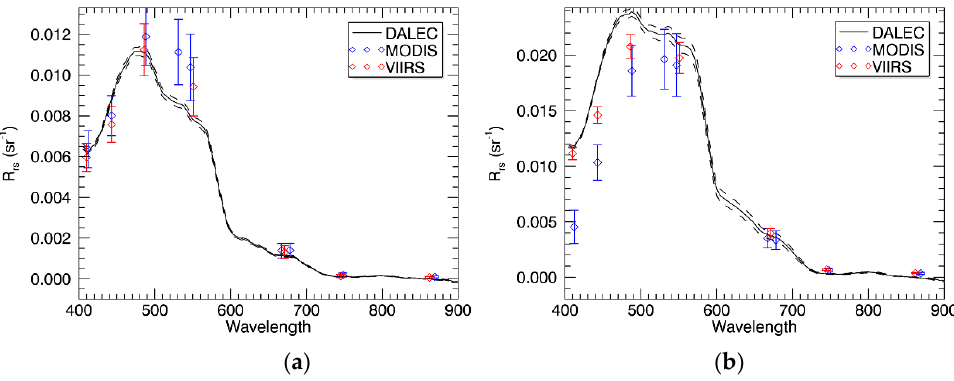
Figure 6. Spectral comparison between DALEC, MODIS and VIIRS near the Integrated Marine Observing System (IMOS) Darwin mooring located in in the Beagle Gulf. ( a ) 24 May 2015; ( b ) 6 August 2015. DALEC mean and standard deviation (dashed lines) over the aggregation period are shown. Error bars on satellite data indicate the standard deviation over a 3x3 neighborhood of pixels.